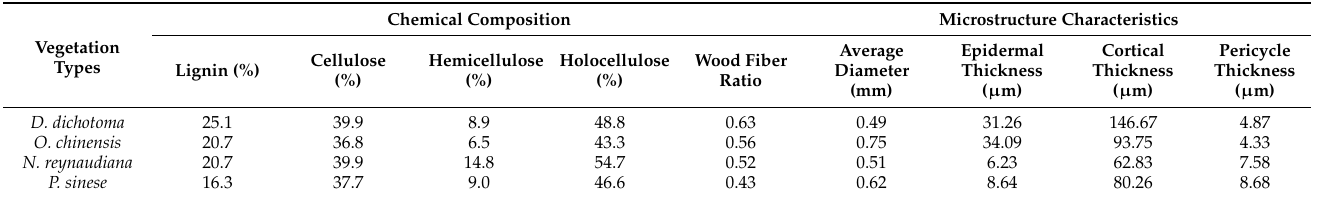
Table 3. The chemical composition and microstructure characteristics of the four herbaceous